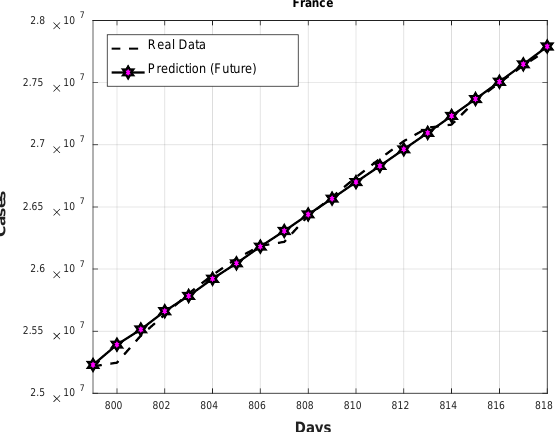
Figure 22. Best future prediction (France).